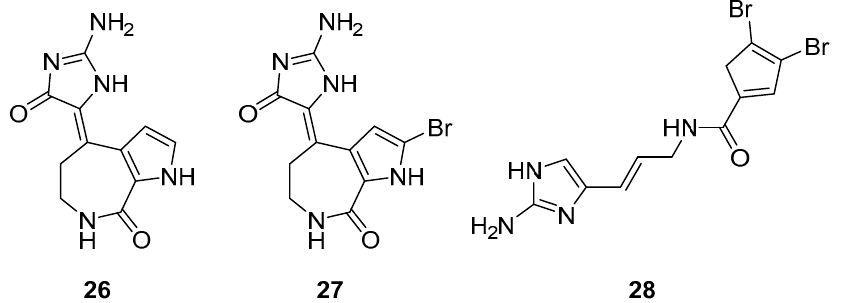
Figure 11. Structures of debromohymenialdisine ( 26 ), 10Z-hymenialdisine ( 27 ), and oroidin ( 28 ).